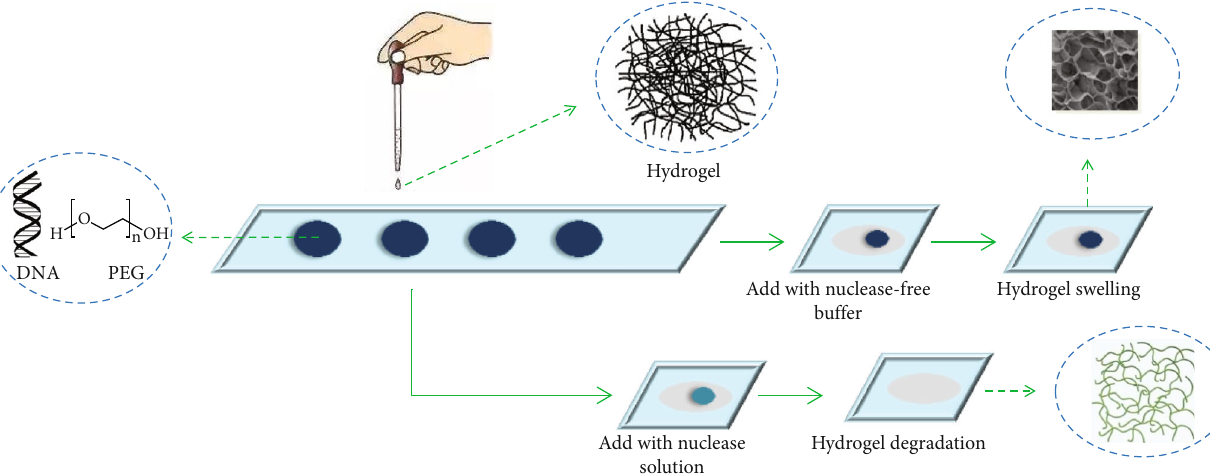
Figure 4: Hydrogel network formation via copper-free click chemistry, followed by hydrogel swelling when immersed in nuclease-free bu ff er or biodegradation when incubated in the presence of